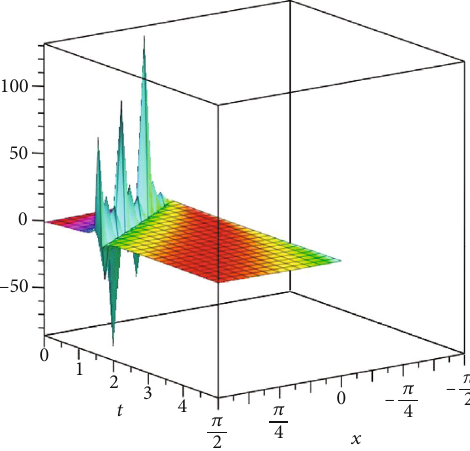
Figure 8: Graphical representation of solution u ð x , y , t Þ given by (29) for t = 0 :: 5, x = − π :: π , for α = 0 : 5 . 2